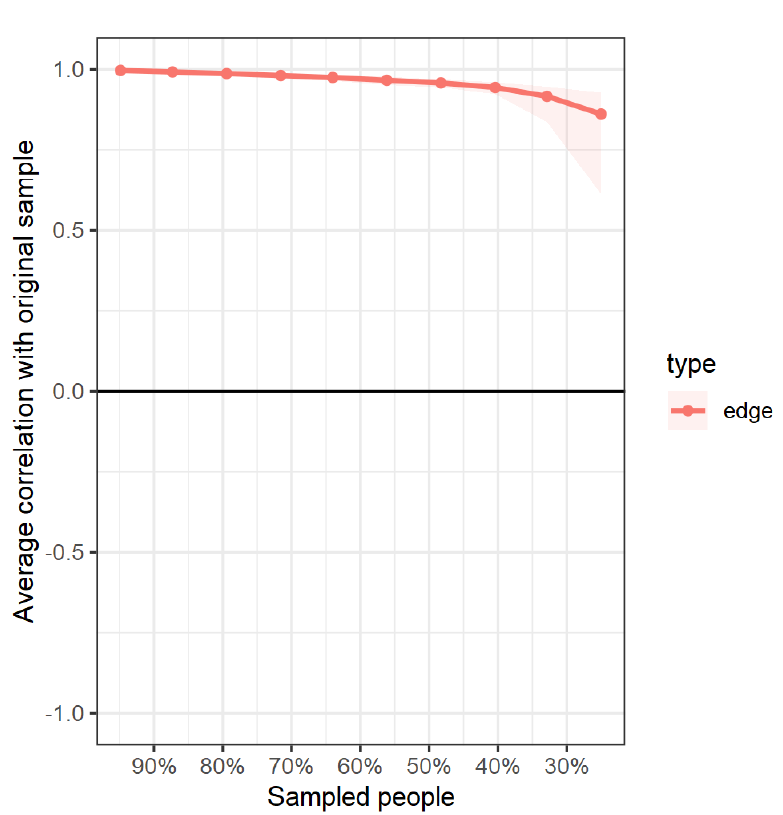
Figure A2. Centrality stability.